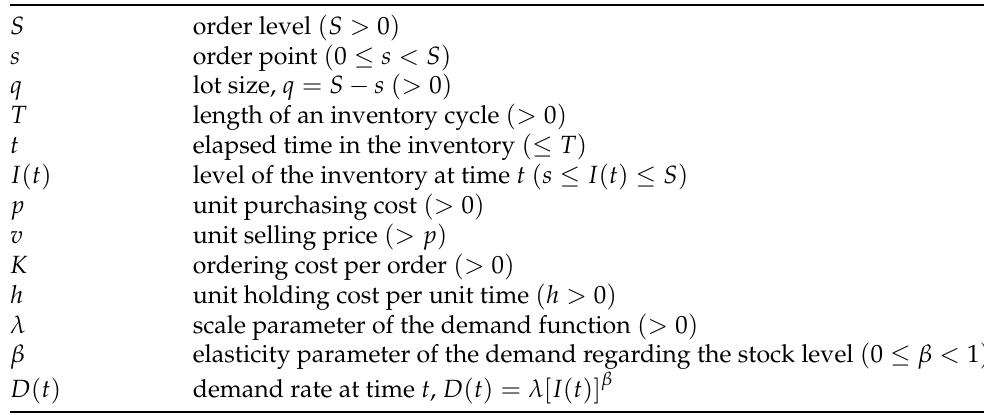
Table 2. Notation for the